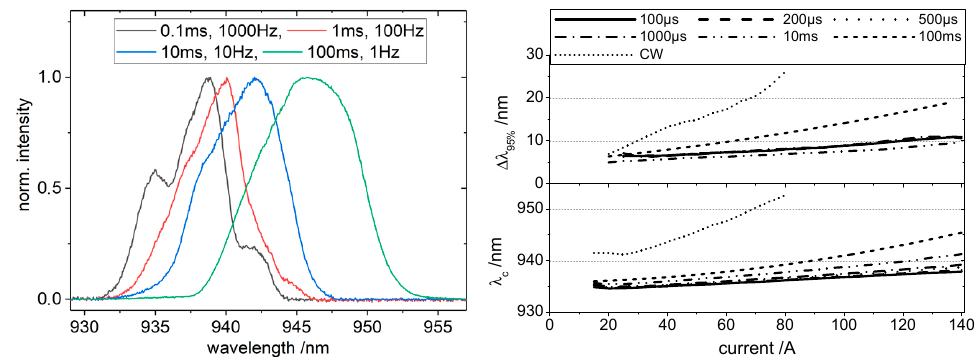
Figure 2. Spectral characteristics for various pulse widths and repetition rates at d.c. = 10% and in cw mode with heat sink temperature of 17 °C. Left : Normalised spatially integrated optical power from fibre as a function of wavelength (pump module) at a drive current of 140 A. Right : Spectral width Δλ 95% with 95% power content (top) and centroid wavelength λ c (bottom) as a function of drive current.